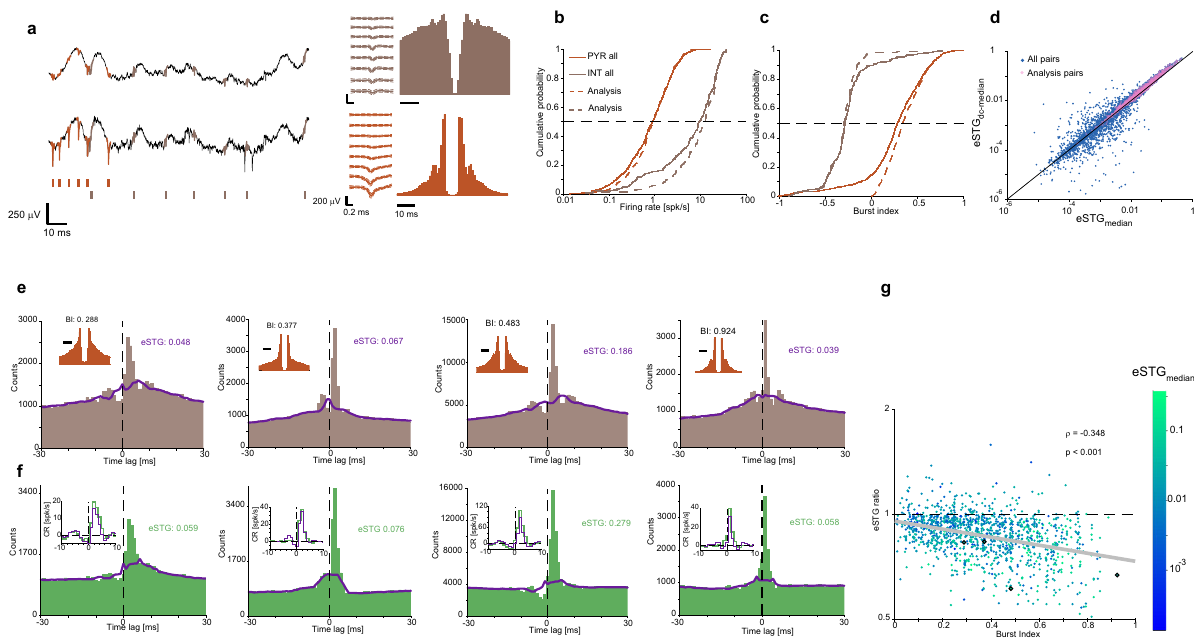
Fig. 6 In real neuronal data, deconvolution-based estimates of spike transmission gain are especially higher in the presence of burst spiking activity. a – c Data were recorded from hippocampal region CA1 of three freely-moving mice using high-density silicon probes. a Example wideband data (band-pass fi ltered 0.1 – 7500 Hz) recorded by two sites on the same shank, separated vertically by 60 μ m. Orange and brown traces and tick marks correspond to PYR and INT spikes, respectively. b Cumulative distributions of the fi ring rates of n = 1041 PYR and n = 215 INT (solid lines). Dashed lines show distributions of n = 611 PYR and n = 152 INT used for further analyses ( d , e ). c Distributions of burst indices of the same four neuronal groups. d In PYR-to-INT pairs with putative monosynaptic connections, STG estimates based on deconvolution are higher than estimates that employ only median fi ltering. Scatter plot shows eSTG dc-median vs. eSTG median for all n = 7991 PYR-to-INT pairs in which both eSTGs were positive. PYR-to-INT pairs with a consistent monosynaptic CCH peak, in which the PYR also exhibits a non-negative burst index, are denoted as “ analysis pairs ” (pink dots; n = 1274 pairs). For the analysis pairs, the eSTG dc-median is higher than the eSTG median ( p < 0.001, Wilcoxon ’ s paired signed-rank test). e Four example CCHs with the median predictor. Insets: The ACHs of the putative presynaptic neurons, which exhibit burst spiking. f dcCCHs for the pairs in ( e ). Insets: Conditional rate (CR) histograms based on the CCHs (purple) and the dcCCH (green). In all examples, the deconvolution-based eSTG is higher than the eSTG estimated without deconvolution. g eSTG ratios for the full dataset ( n = 1274 pairs), shown as a function of the presynaptic burst index. Deconvolution-based estimates are consistently higher than estimates without deconvolution ( p < 0.001, Wilcoxon ’ s signed-rank test). Estimates are particularly higher when spike bursting is more prevalent ( p < 0.001, permutation